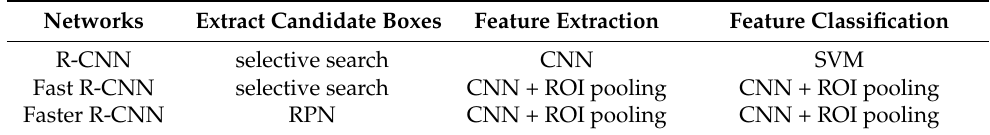
Table 1. Comparison of the three network